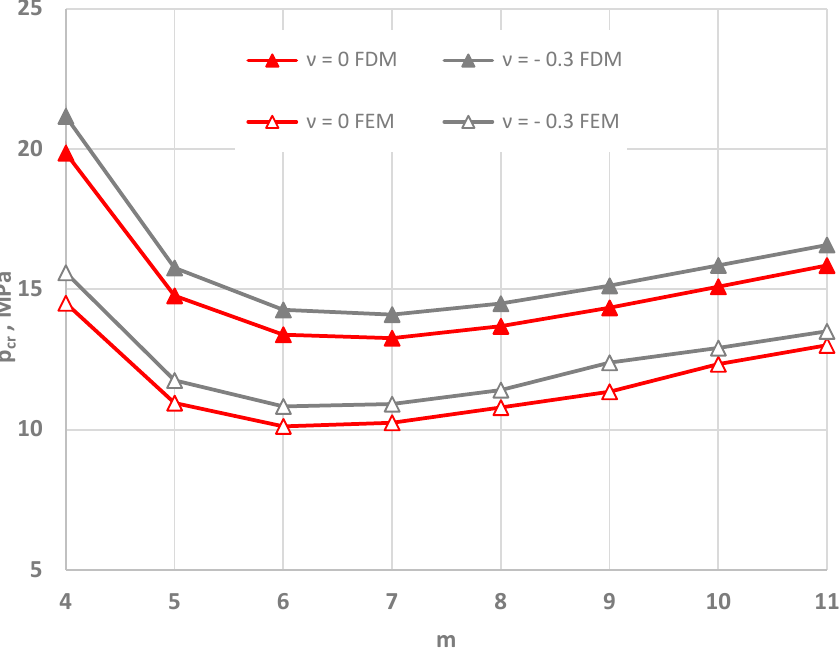
Figure 10. Critical static load p cr distribution versus mode m for the FDM and FEM three-layered plate models radially stretched on the inner edge.